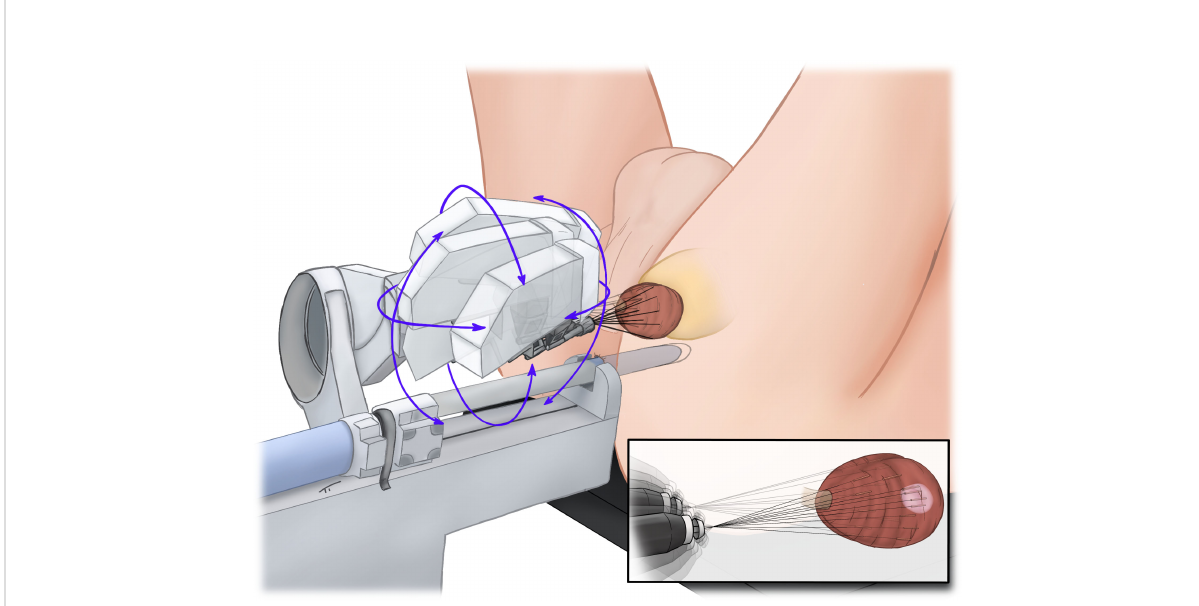
FIGURE 1 Robotic-assisted transperineal MRI-TRUS-fusion guided biopsy of the